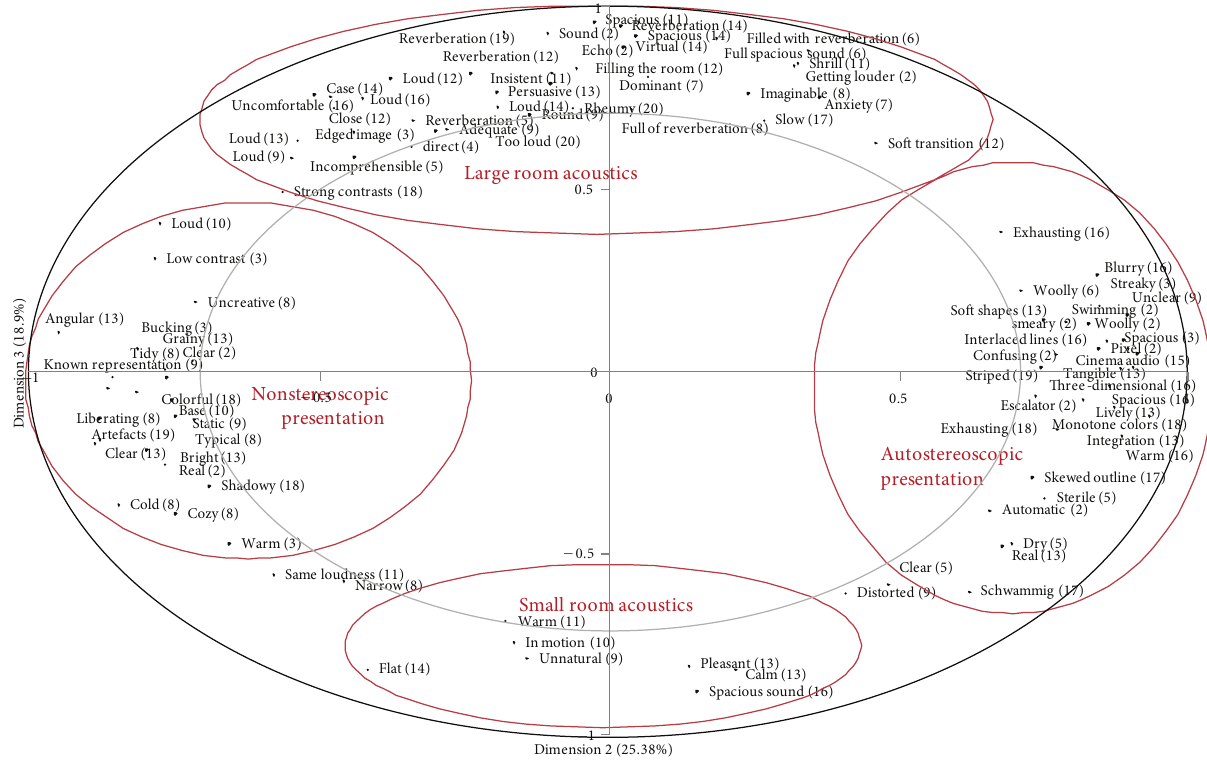
Figure 8: PCA correlation loadings with attributes in the space of PC2 and